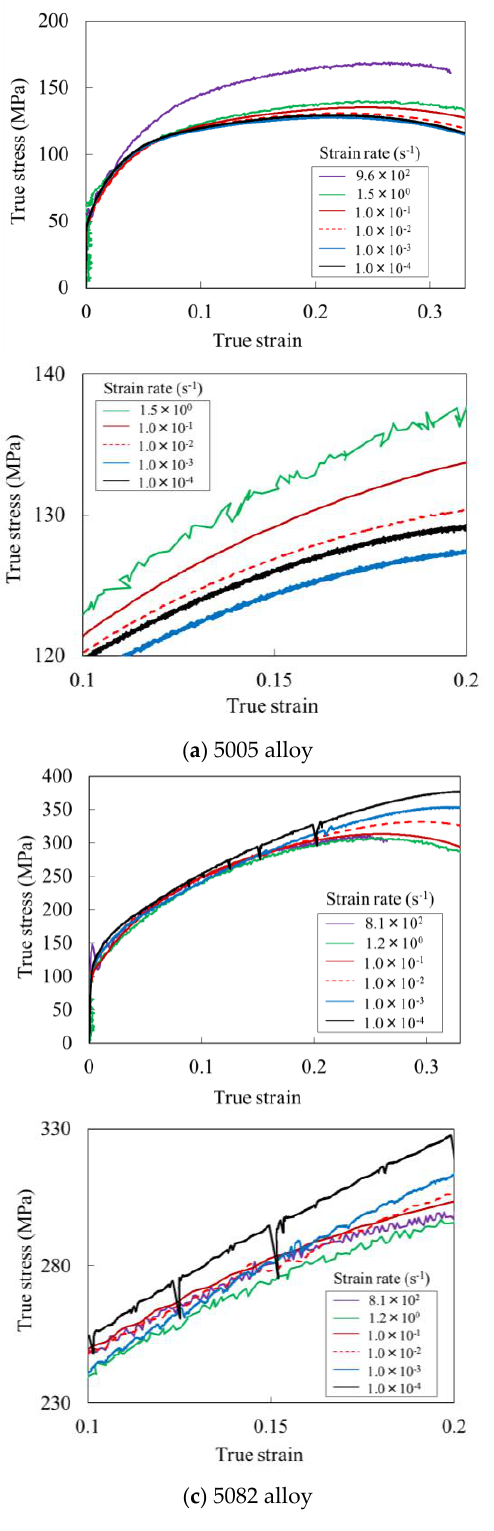
Figure 5. Stress–strain relationship of ( a ) 5005 alloy, ( b ) 5021 alloy, ( c ) 5082 alloy, and ( d ) 5182 alloy and these enlarged views.